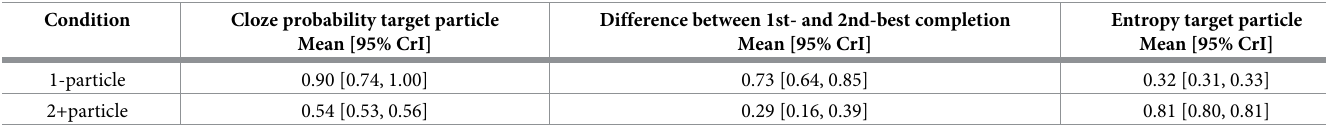
Table 1. Cloze probability and entropy summary statistics for Experiment